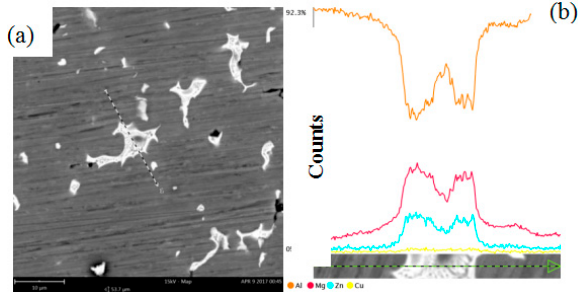
Figure 7. ( a ) Al-Mg-Zn eutectic phase leading to micro-cracks and ( b ) its energy-dispersive spectroscopy (EDS) line scan.